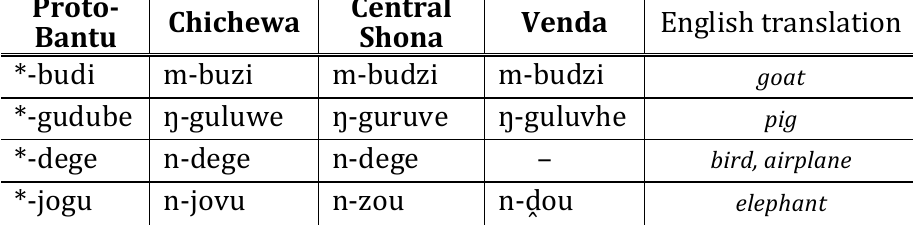
1092 J. Table 2: Synchronic outcomes of Proto-Bantu *ND for words in Class 9/10